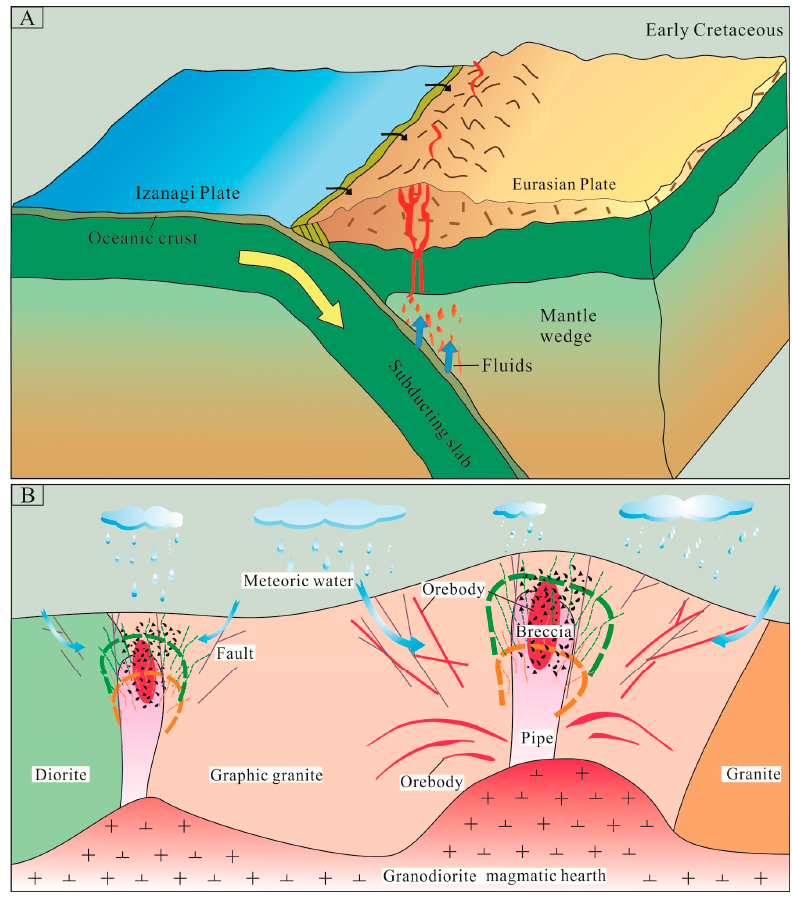
Figure 13. ( A ) Tectonic model of Early Cretaceous gold deposits in the Jinchang area (after Sun et al. [68]). ( B ) Metallogenic model for the Jinchang deposit.